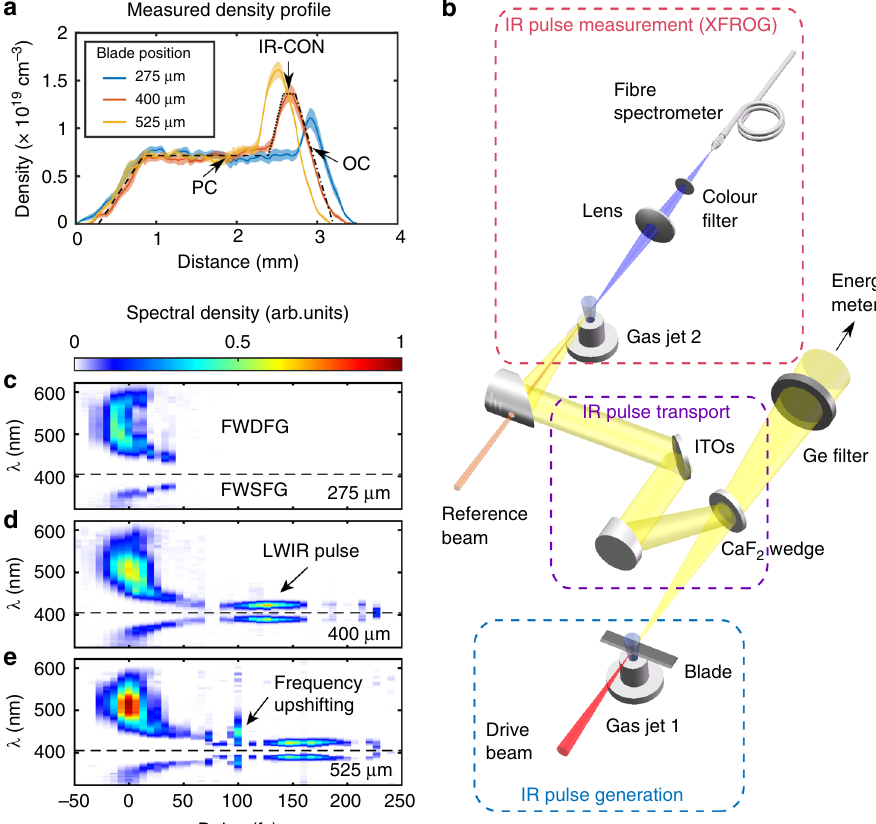
Fig. 1 Density pro fi les, experimental setup, and XFROG results. a The measured on-axis plasma densities (the blurred curves show the RMS spread of the data) at different blade positions (275, 400, and 525 μ m from the edge of the opening) into the gas jet. The resulting plasma density pro fi le has three distinct regions — PC: pulse compressor (black dashed line); IR-CON: IR converter (black dotted line); OC: output coupler (black dash-dot line). b Schematic of the experimental setup. In the IR pulse generation section, the drive laser (red) is focused onto Gas jet 1 (hydrogen) with a movable blade to interact with the plasma structure (see “ Methods ” ). In the IR pulse transport section, the transmitted light from Gas jet 1 is split by a CaF 2 wedge into two beams: one is sent after being fi ltered by an uncoated Ge plate to energy meter for IR energy measurement; the other is fi ltered (ITOs) and coupled to the XFROG device — Gas jet 2 (argon) followed by a spectrometer. c – e The measured XFROG traces for the corresponding plasma density pro fi les shown in ( a ). The black dashed lines mark the position of 405 nm ( λ ref /2). Both four-wave difference-frequency and sum-frequency generated spectra (FWDFG and FWSFG, respectively) can be